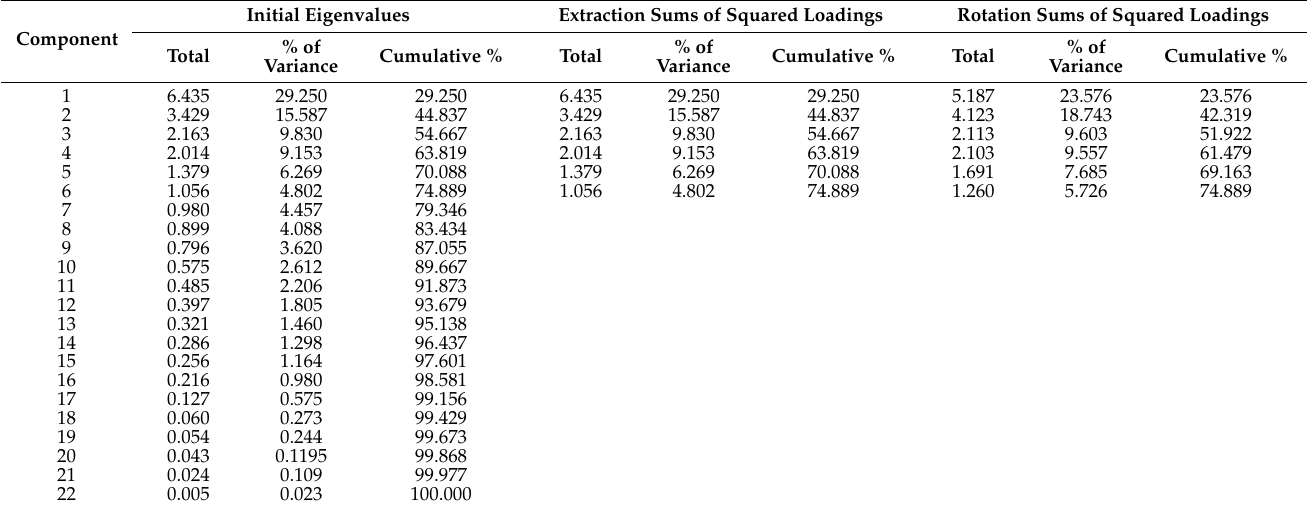
Table A1. Results of the factor analysis. Total variance explained.